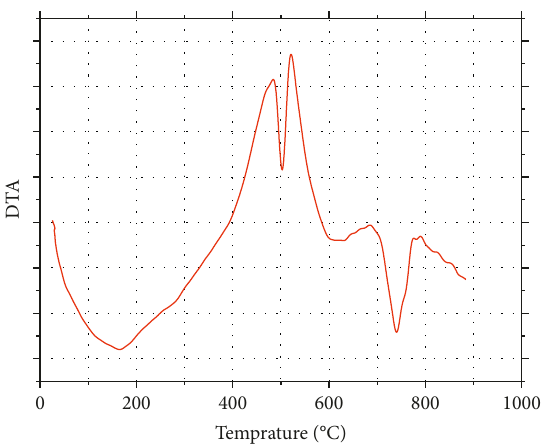
Figure 14: DTA for CHA 10% replacement sample, 28 th